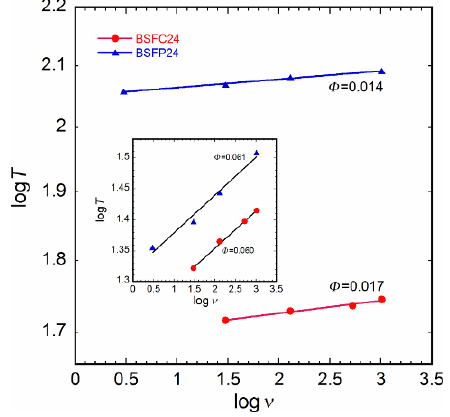
Fig. 7 Plot of log( ) T vs. log( )  for the high- temperature peak (main panel) and low-temperature (inset) peak of   for both BSFC24 and BSFP24